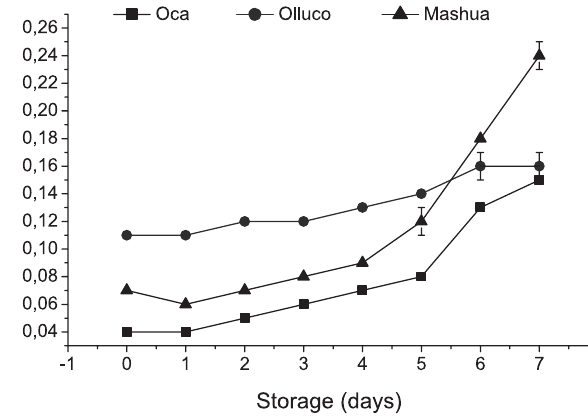
FIGURE 3 - Effect of storage on the paste opacity of oca, olluco and mashua